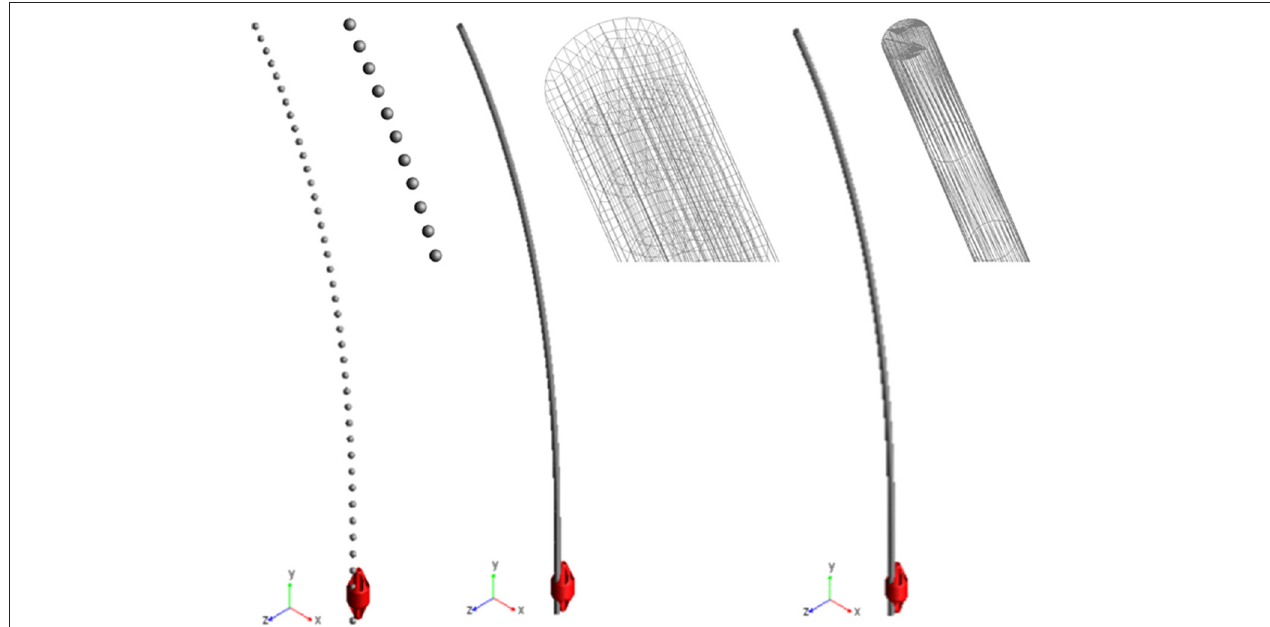
FIGURE 2 | Three modeling solutions for nails. From left to right: lumped mass and stiffness elements, flexible body (MNF), FE Part.